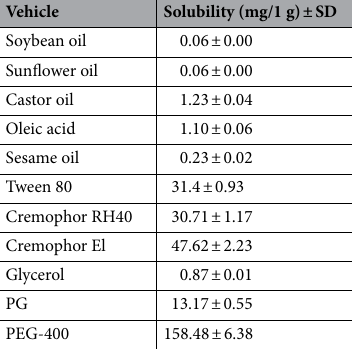
Table 2. The solubility of FUR in various oils, surfactants, and co-solvents (mean ± SD, n = 3).